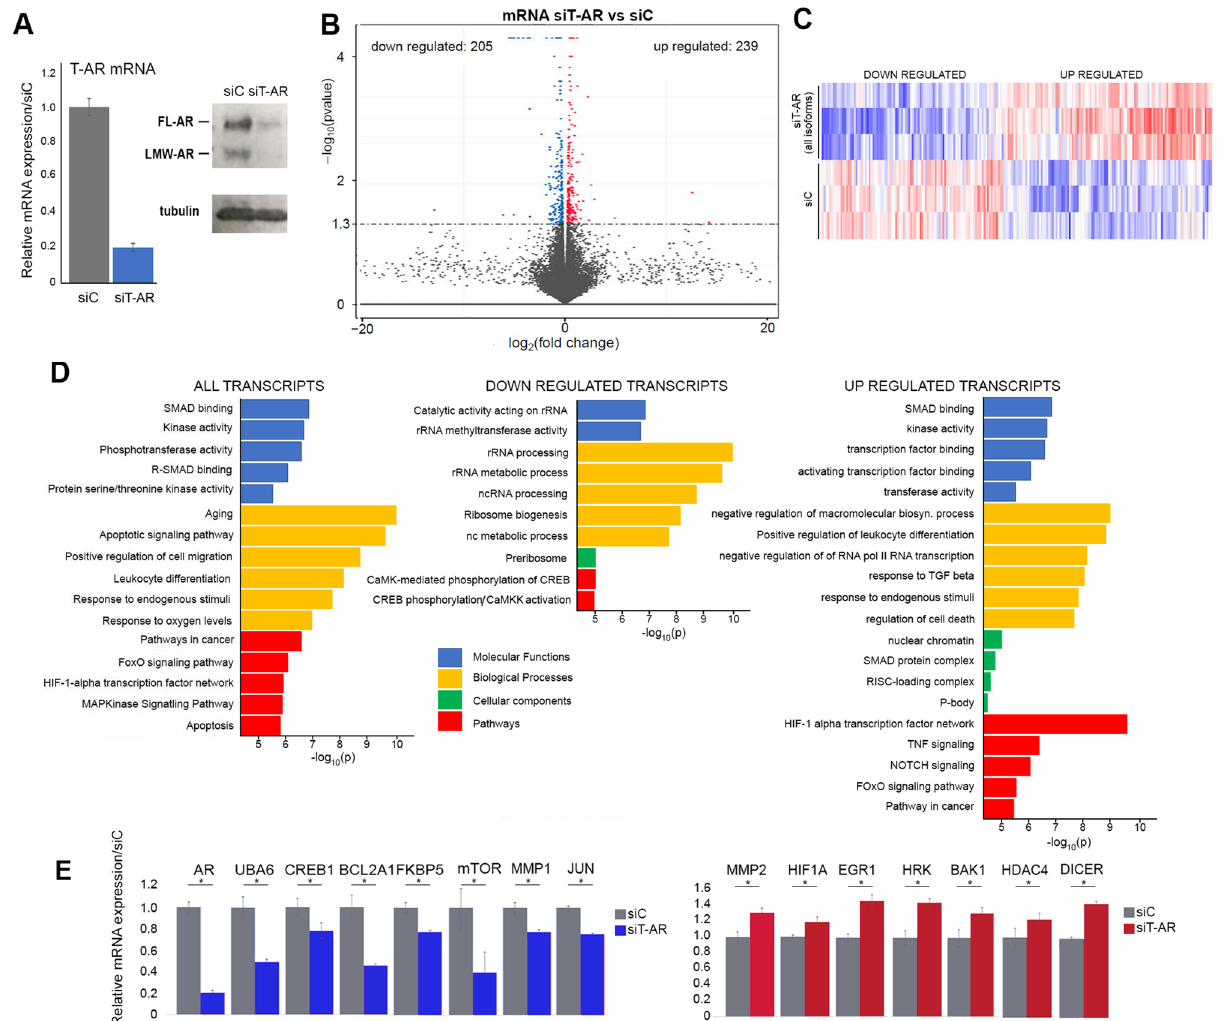
Figure 2. Transcriptome changes following depletion of all AR isoforms in UM-UC-3 cells. ( A ) qRT-PCR (left) and immunoblot analysis (right) validated successful depletion of all AR isoforms following a three- day treatment with AR targeting siRNA. ( B ) Volcano plot analysis indicates similar number of transcripts are repressed (blue) and activated (red) on depletion of all AR isoforms. ( C ) Partial heat map of transcripts repressed and activated on AR depletion when compared to controls. ( D ) Gene enrichment analysis identifies statistically significant molecular function (blue), biological processes (yellow) cellular components (green) and pathways (red) altered on AR depletion. The analysis was conducted on all transcripts (left panel), down regulated transcripts (middle panel) and up regulated transcripts (right panel). ( E ) qRT-PCR verified AR-dependent alterations of selected transcripts. All qRT- PCR analysis was conducted in triplicate. * P -value < 0.05. Immunoblots were cropped prior to incubation with specific